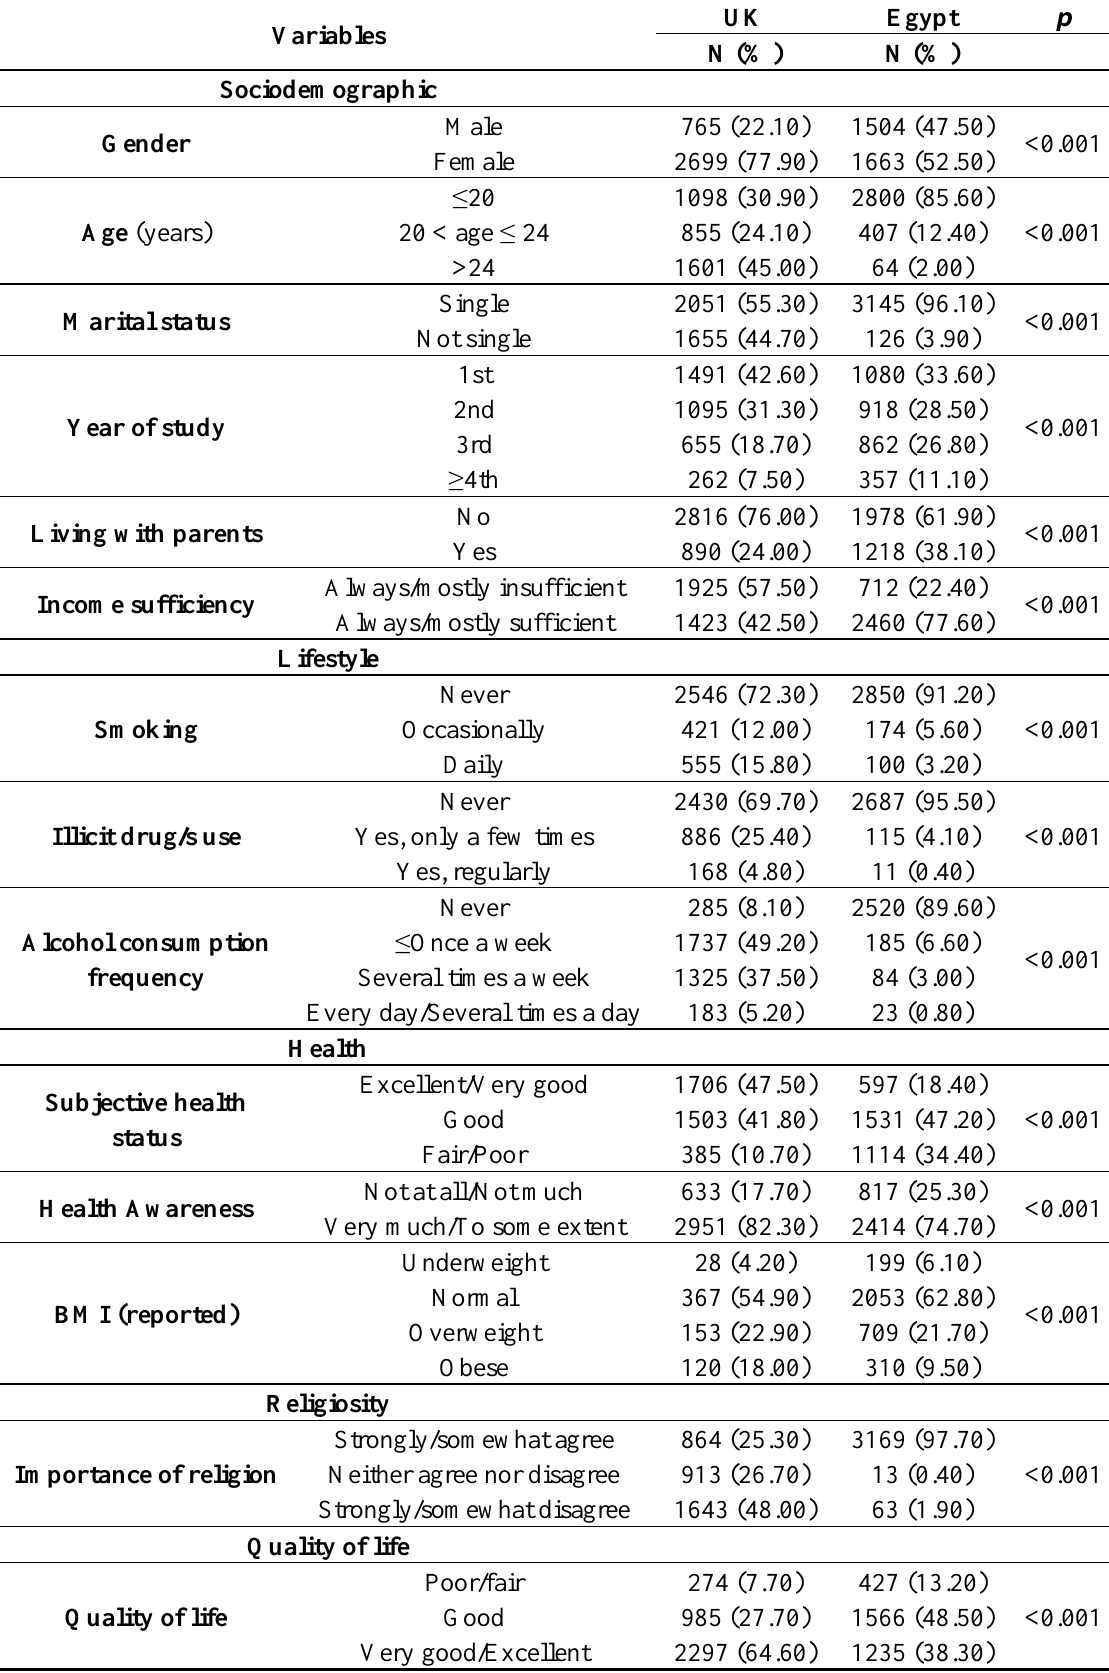
Table 1. General characteristics of the United Kingdom and Egypt samples.